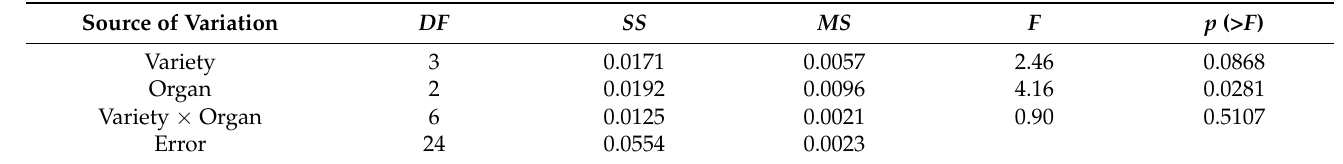
Table 6. The joint ANOVA of the 72h larval weight gain in different varieties and different